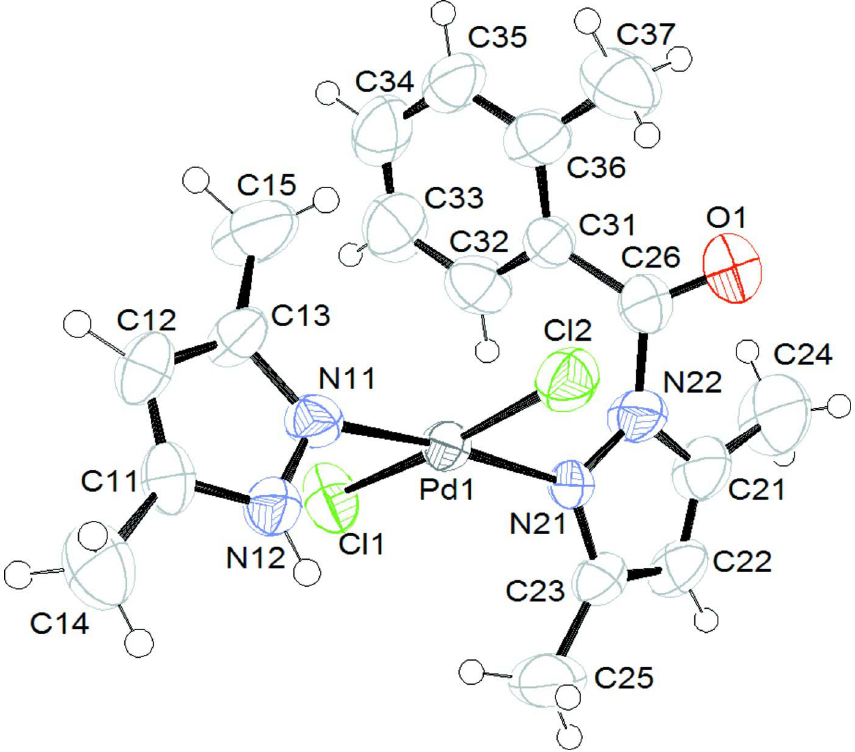
The molecular structure of (I), with displacement ellipsoids drawn at the 50% probability level (arbitrary spheres for the H